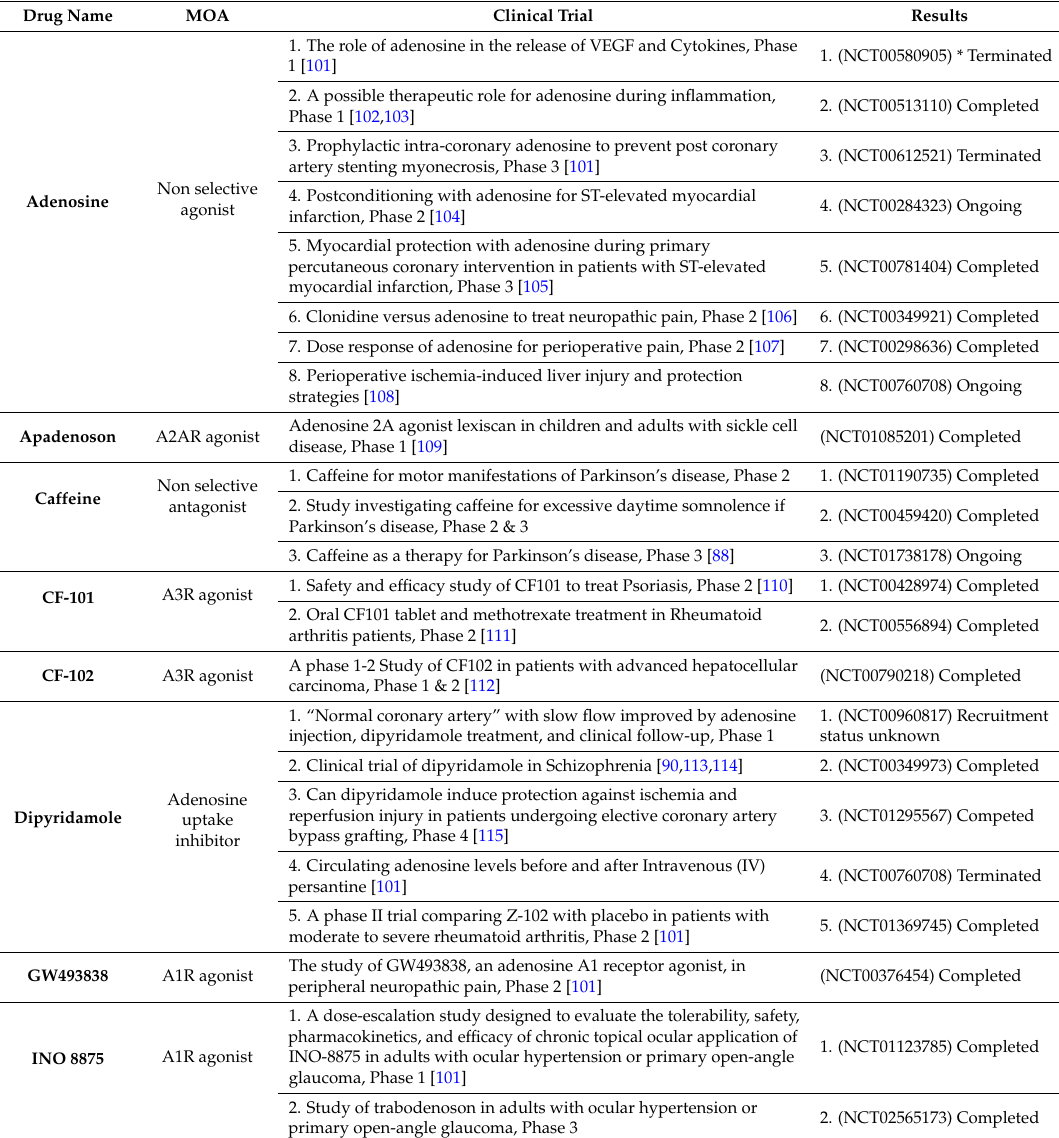
Table 2. Name, mechanism of action (MOA), use in Clinical trials and potential role of Adenosine A1, A2A, and A3 receptor agonists and